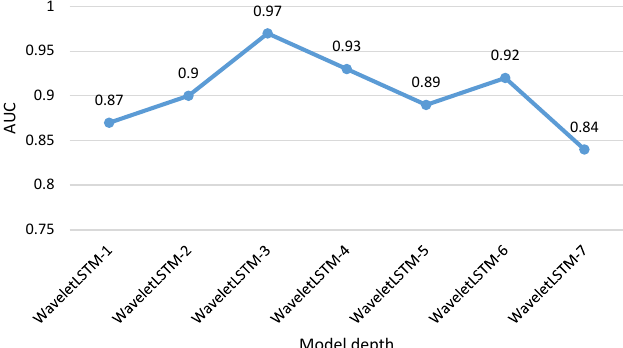
Figure 13. Detection performance of WaveletLSTM with different scales.